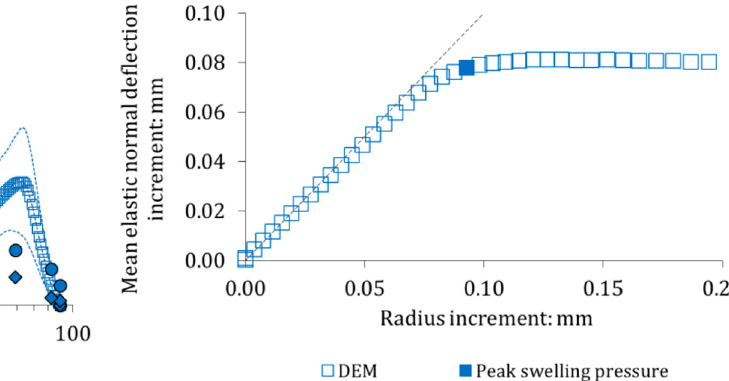
Fig. 6. Comparison of experimental and numerical evolution of swelling pressure upon suction decrease. Dashed lines represent a two-standard-deviation interval of numerical simulation results.